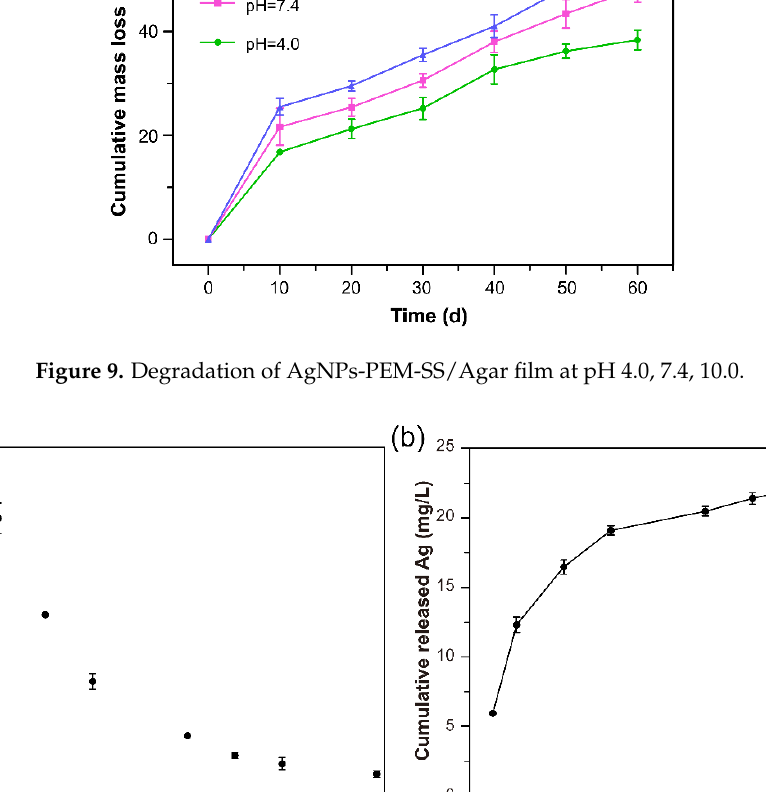
Figure 10. Release profile of silver from the AgNPs ‐ PEM ‐ SS/Agar film in PBS buffer. ( a ) non ‐ cumulative and ( b ) cumulative release of Ag after treatment at 37 °C for 108